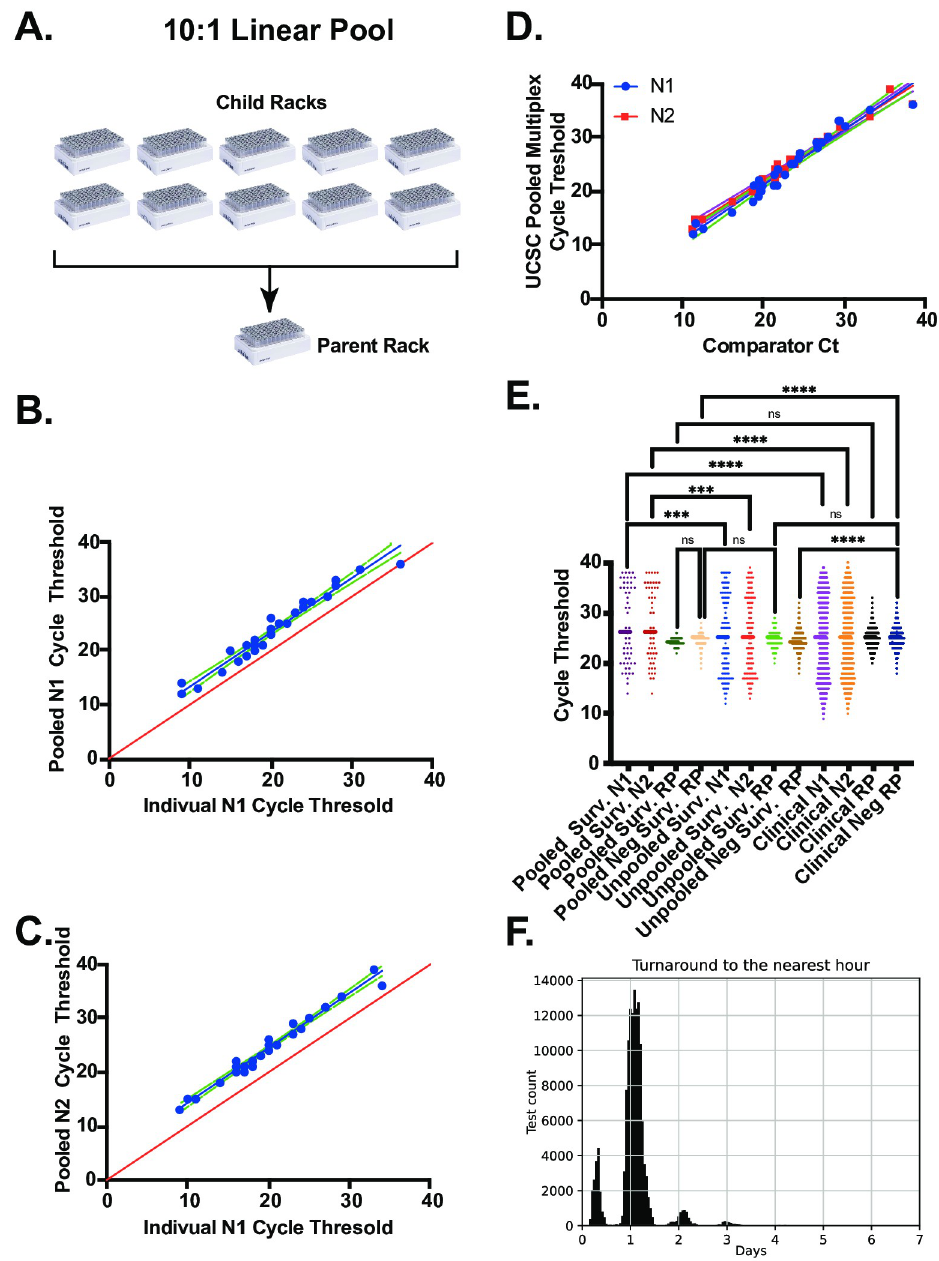
Fig 2. Validation of a pooled sample testing strategy for campus-wide SARS-CoV-2 surveillance. (A) 10:1 linear pooling strategy. Upto 10 individual sample racks (children) are combined into a single pooled sample (parent) rack. (B) UCSC multiplex N1 assay on 30 individual or pooled positive samples. (C) UCSC multiplex N2 assay on 30 individual or pooled positive samples. (D) Analysis of pooled positive samples with the UCSC multiplex or comparator assay. N1 amplicon (blue) and N2 amplicon (red). (E) Overall performance of the UCSC multiplex assay on thousands of clinical, surveillance and pooled surveillance samples. (F) Turnaround time for both clinical and surveillance samples, rounded to the nearest